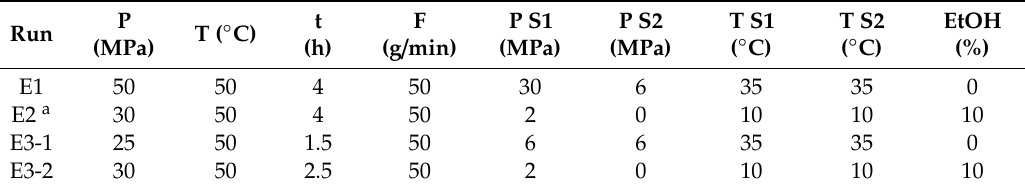
Table 1. Experimental conditions for the supercritical fluid extraction of heather, marigold and combined heather + marigold (50:50) extraction. (P) pressure, (T) temperature, (t) time, (F) flow rate, (P S1) pressure in separator 1, (P S2) pressure in separator 2, (T S1) temperature in separator 1, (T S2) temperature in separator 2, (EtOH) mass of ethanol (w / w) used as a